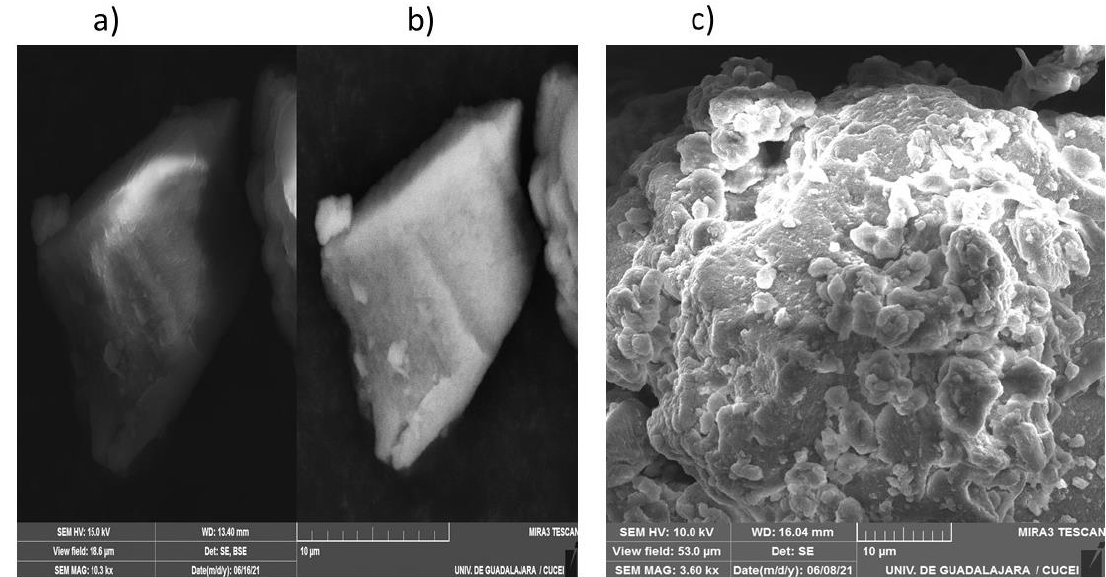
Figure 6. SEM micrographs of ( a ) pristine SG-LGPS adsorbent with secondary electron detector, ( b ) pristine SG-LGPS adsorbent with scattered electron detector, ( c ) adsorbent after malathion adsorption, SG-LGPS-ML with scattered electron detector.